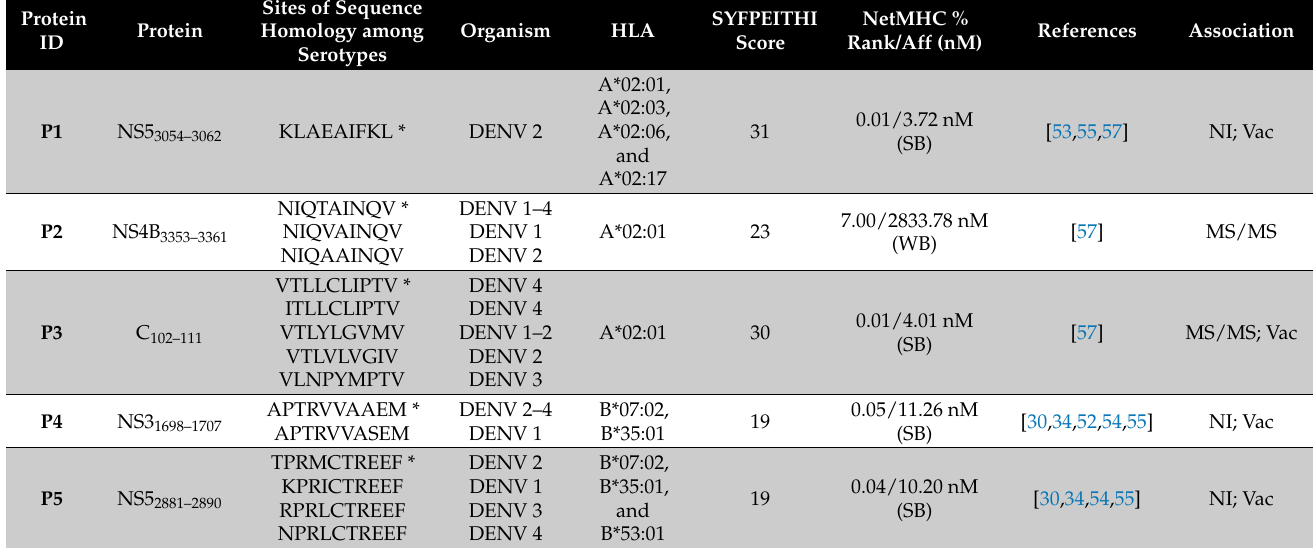
Table 1. DENV-derived peptides identified by the Immune Epitope Database. The HLA-A*02- or HLA-B*07-restricted peptides epitopes identified by this method were located in the DENV non-structural (NS) proteins 3, 4B, and 5 as well as the capsid (C) protein. The peptides indicated were described previously in studies on natural infection (NI) or vaccines (Vac), or based on MS/MS epitope predictions (MS/MS). The selected epitopes utilized in this study are indicated with an asterisk (*). NetMHC 4.0 and SYFPEITHI HLA binding affinity (Aff) estimation scores predict that 4 of the 5 peptides will be strong binders (SB) to HLA-A*02 or HLBA-B*07. Strong and weak binding (WB) peptides were defined as % rank < 0.5 and > 2,